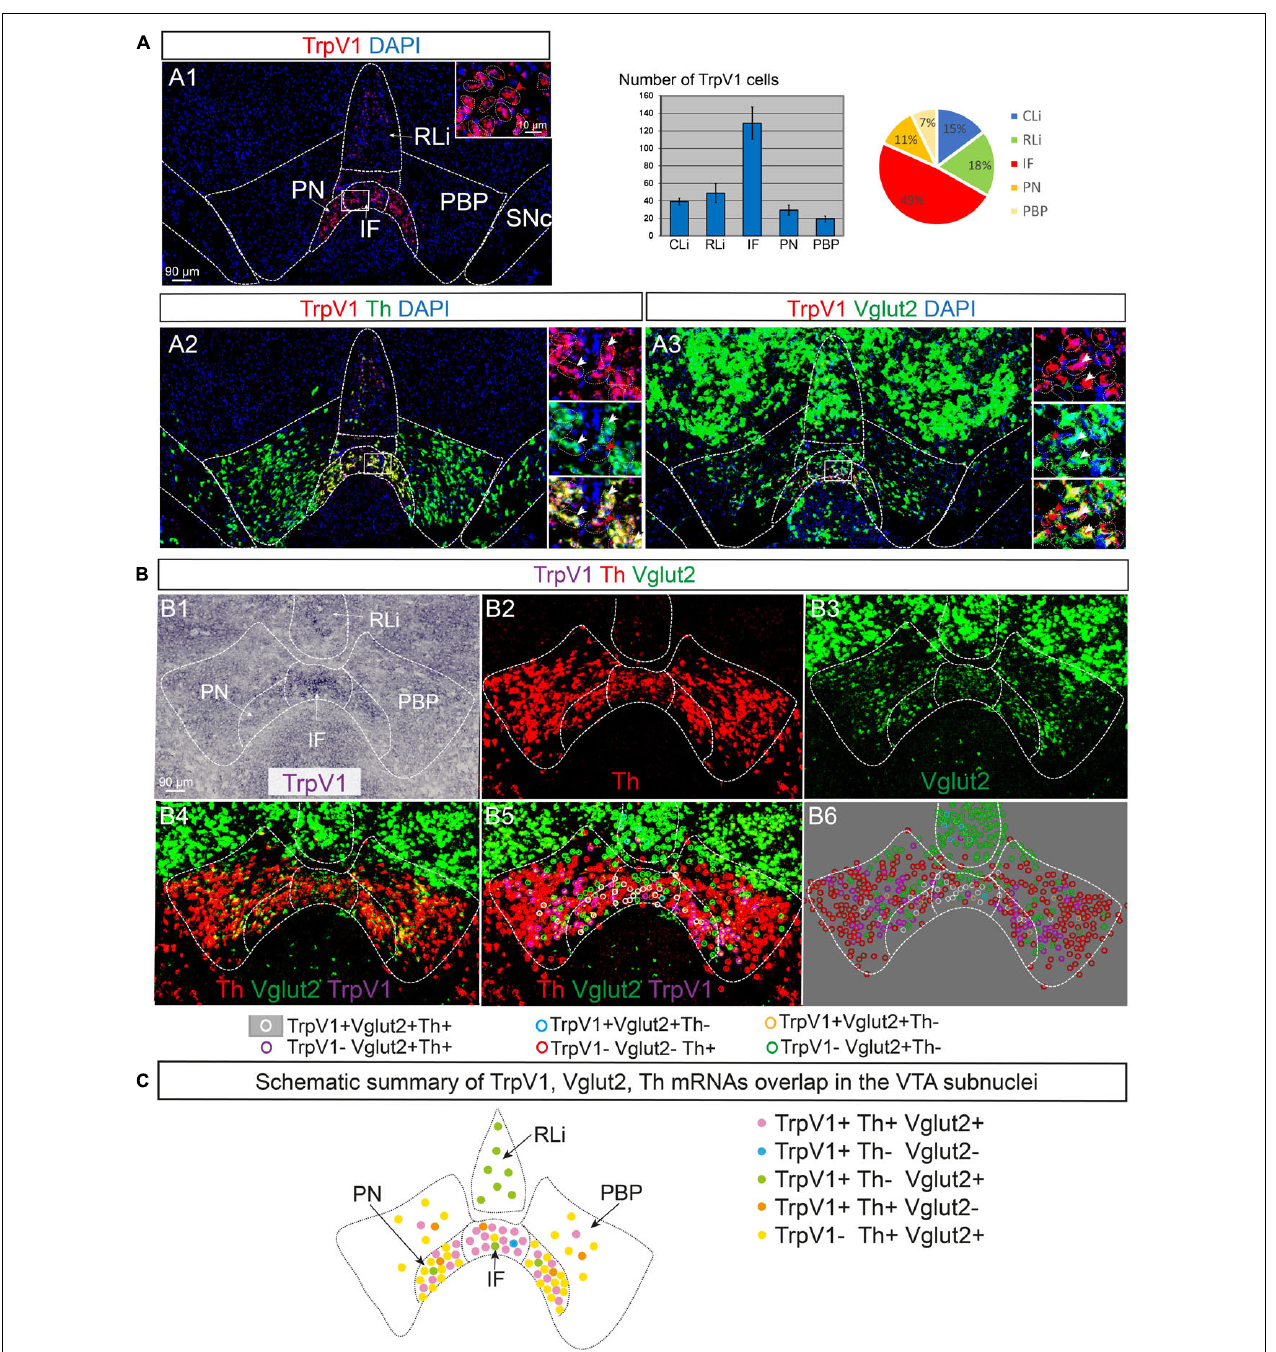
FIGURE 2 | TrpV1 mRNA primarily in medial VTA subnuclei co-localizes strongly with Th and Vglut2 mRNAs. TrpV1, Th, and Vglut2 mRNAs were analyzed by fluorescent and colorimetric in situ hybridization (FISH and CISH) in serial coronal brain sections at postnatal day (P) 3. DAPI is used for the detection of cell nuclei. (A1–A3) FISH: TrpV1 ( A1 ; a table and a pie chart show result of counting of TrpV1-positive cells per VTA subnucleus, N = 3 mice, serial sections throughout the VTA, allowing for analysis of adjacent sections); TrpV1/Th (A2) ; TrpV1/Vglut2 (A3) ; closeup’s in insets; cells indicated by dotted lines. The yellow color indicates colocalization of red and green fluorophores. FISH-positive cells are indicated in insets by arrowheads; white arrows indicate co-labeling of red and green fluorophores. (B) Triple labeling by combined CISH/FISH visualized in separate channels (B1–B3) and merged (B4) : TrpV1 ( B1 , CISH), Th ( B2 , FISH), Vglut2 ( B3 , FISH), merged TrpV1/Th/Vglut2 (B4) ; colored circles indicate double and triple mRNA labeling ( B5 histological section; B6 -colored circles indicating positive cells in B5 superimposed on gray background for clarity; B5,B6 legends indicate mRNA detected per colored circle). (C) A schematic summary of results in (A,B) , an illustrated map of TrpV1/Vglut2/Th overlap in VTA subnuclei. Scale bars, 90 µ m; 10 µ m (insets). See Table 1 for cell counting. IF, interfasicular nucleus; PN, paranigral nucleus; PBP, parabrachial pigmented nucleus; RLi, rostral linear nucleus; VTA, ventral tegmental area.